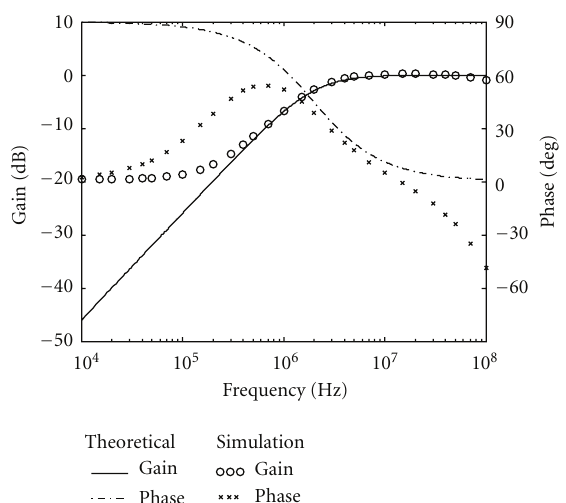
Figure 8: Simulation results of the proposed current-mode second- order allpass